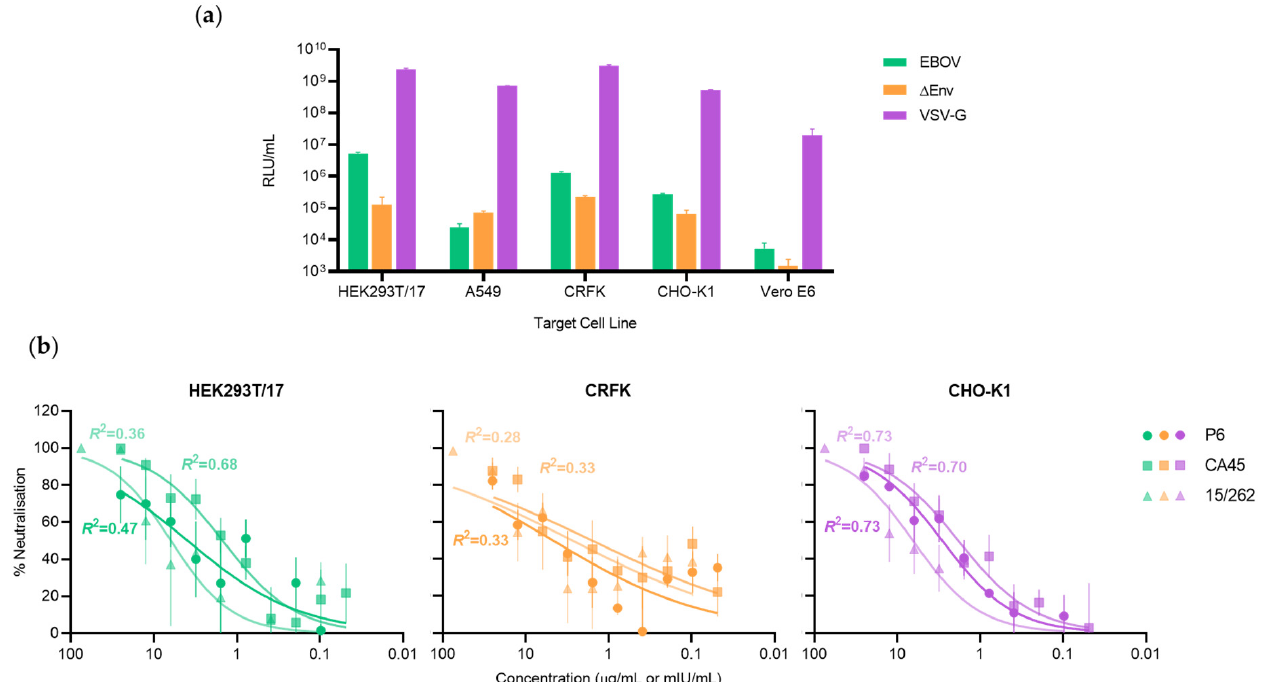
Figure 1. Comparison of EBOV-pseudotyped virus infectivity and neutralisation on various target cell lines. ( a ) Infectivity of the EBOV-pseudotyped lentiviral particles measured as relative luminescent units (RLU/mL) were assessed on 5 target cell lines. A vesicular stomatitis virus G protein (VSV-G) pseudotype was used as a positive control for the LVV system. LVV without an envelope protein ( ∆ Env) was used to determine the background signal. ( b ) The percentage neutralisation of dilutions of monoclonal antibodies P6 or CA45 ( µ g/mL) and WHO IS (20/262; mIU/mL) following incubation with 50 TCID 50 of EBOV-pseudotyped virus on each of the target cells, with the fit ( R 2 ) of the dose-response curve annotated. Error bars indicate SEM ( n =